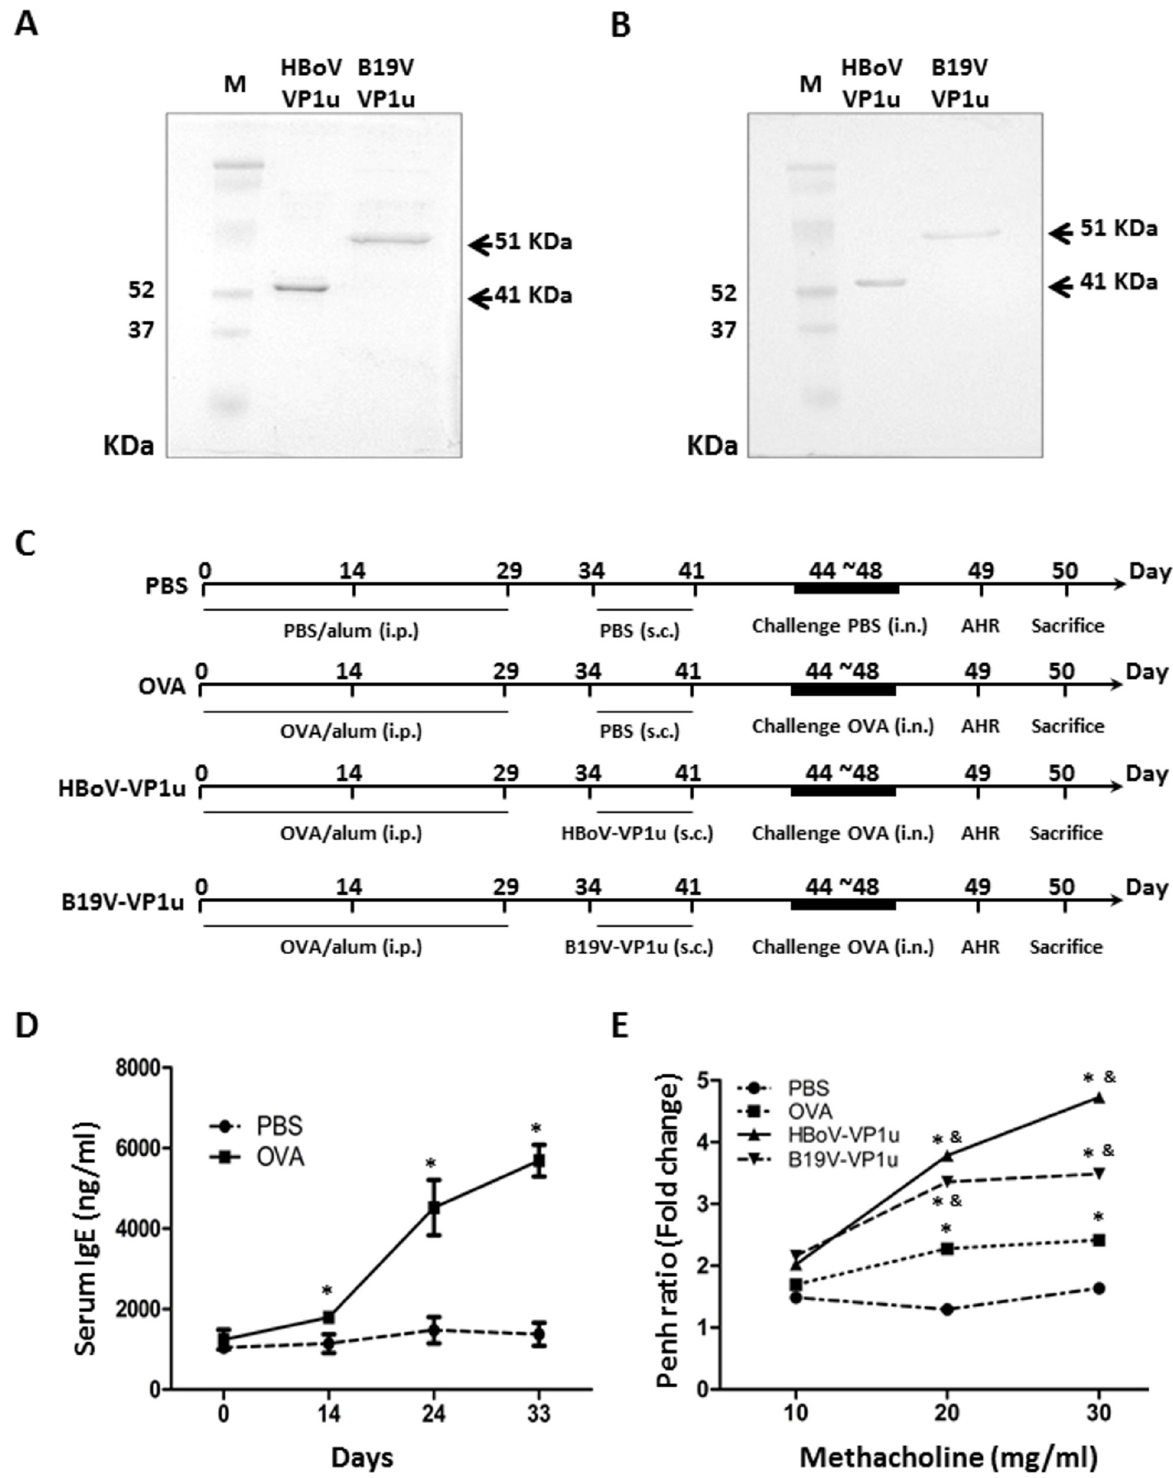
Fig 1. The mouse models of allergic asthma. (A) The purified HBoV-VP1u and B19V-VP1u recombinant was observed on SDS-PAGE and (B) detected with immunoblotting by probing with antibodies against histidine tag (6x His). (C) The protocols used for the four mouse models of allergic asthma. (D) Serum level of IgE in mice from PBS and OVA groups on day 0, 14, 24 and 33. (E) The fold change of enhanced pause (Penh) of mice. Values are mean ± SD. Similar results were observed in three repeated experiments. � and & indicate significant difference, p < 0.05, relative to PBS and OVA groups, respectively. (n = 5 for each